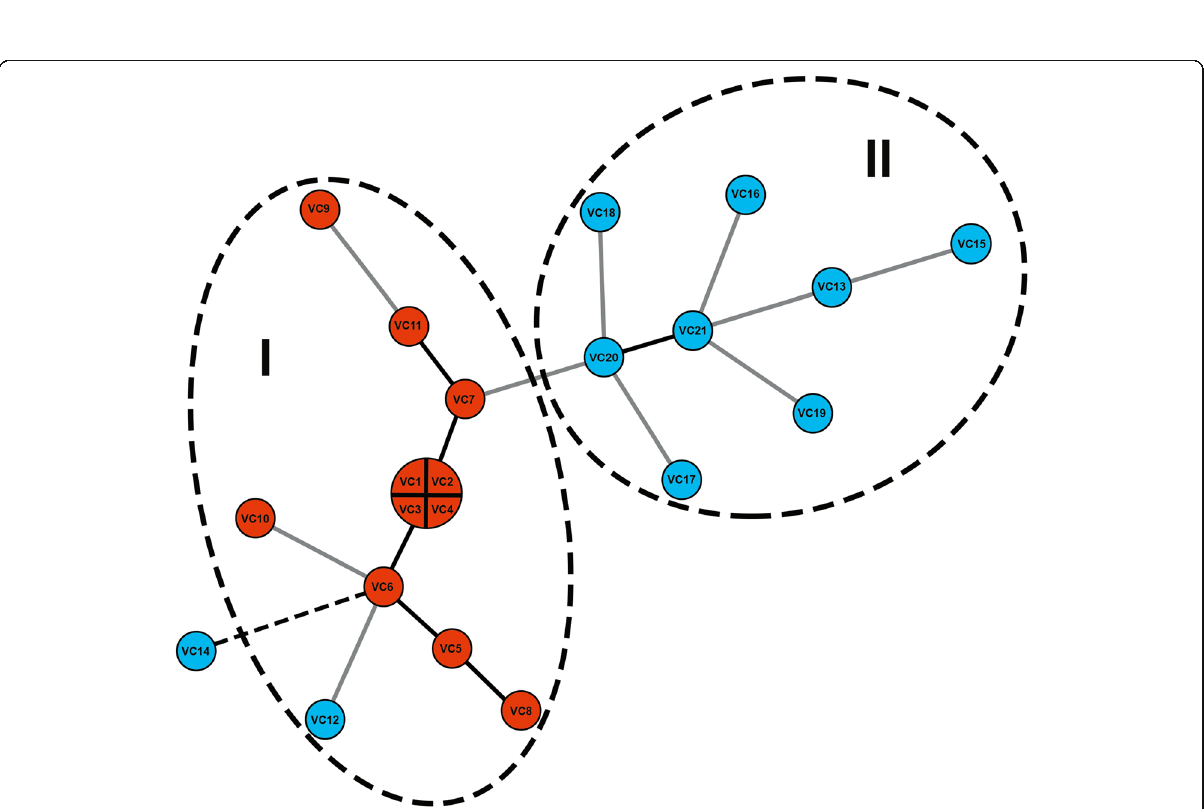
Fig. 2 Minimum spanning tree of the 21 V. cholerae isolates based on MLVA profiles. Each circle represents a unique MLVA profile. The color of the circles corresponds to serogroups. The circle size is proportional to the number of isolates. A distance of one locus between two MLVA profiles is indicated by a thick line, a distance of two loci is indicated by a gray line, and a distance of three loci is indicated by a dot line. The dotted circle indicates the MLVA clusters (I and